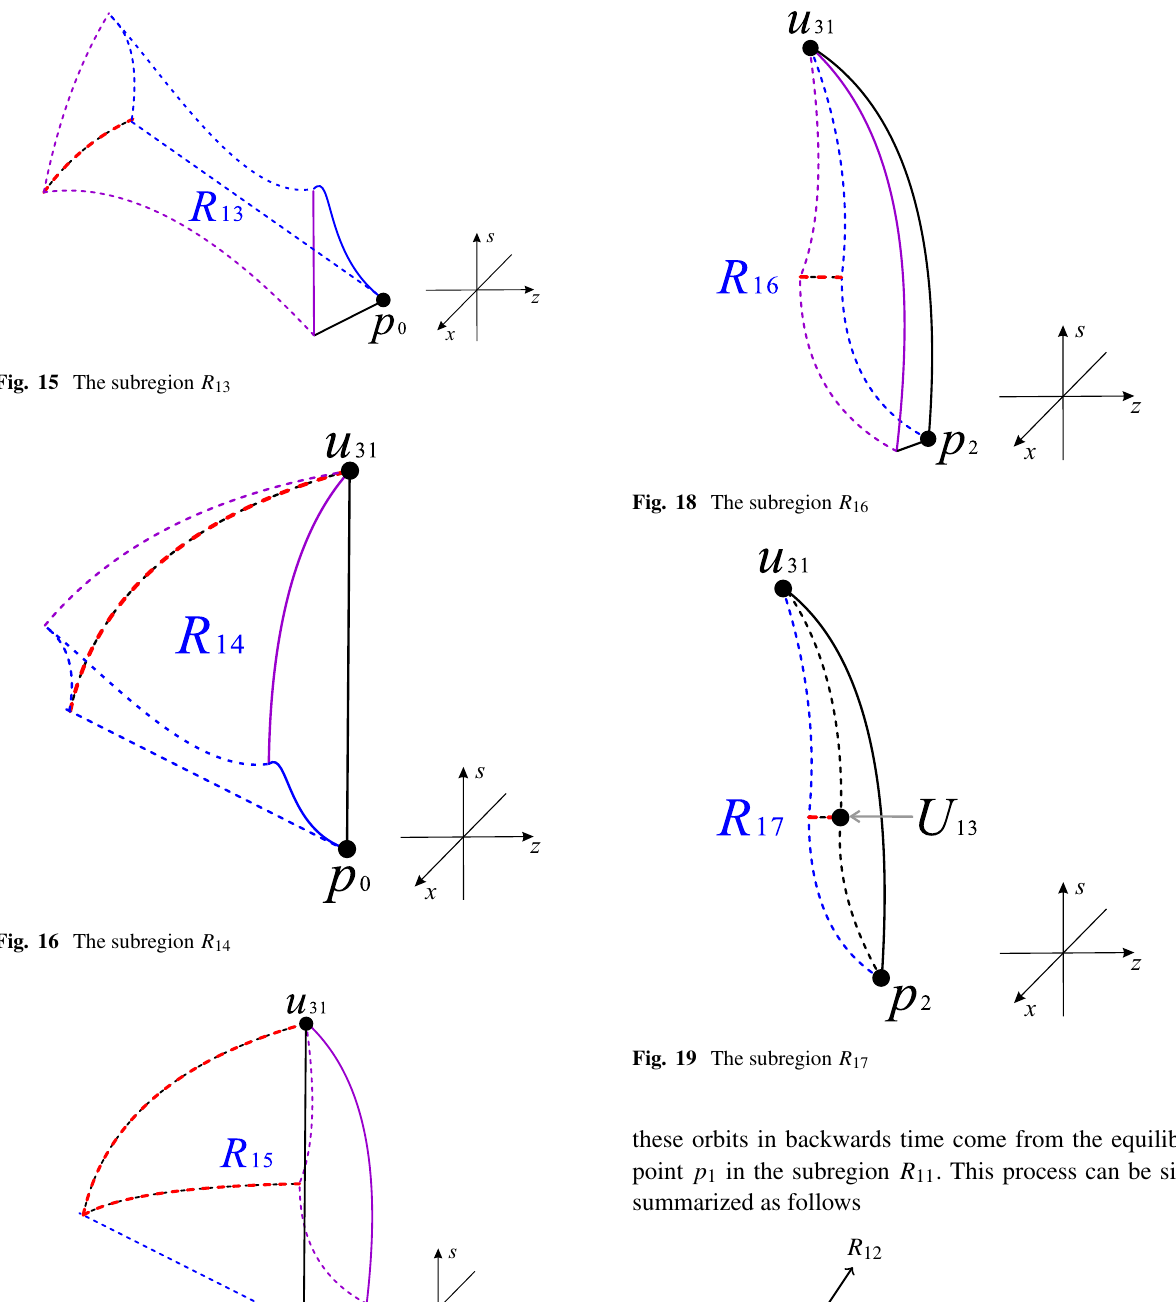
Fig. 15 The subregion R 13